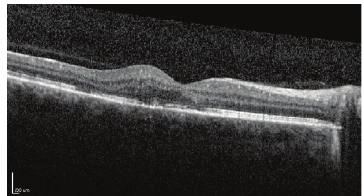
Figure 4: The optical coherence tomography image of the same subject presented in Figures 1–3 two months after two consecutive monthly bevacizumab injections were given. Notice the resolution of most of the retinal fluid and the choroidal neovascularization diminishment within the subretinal